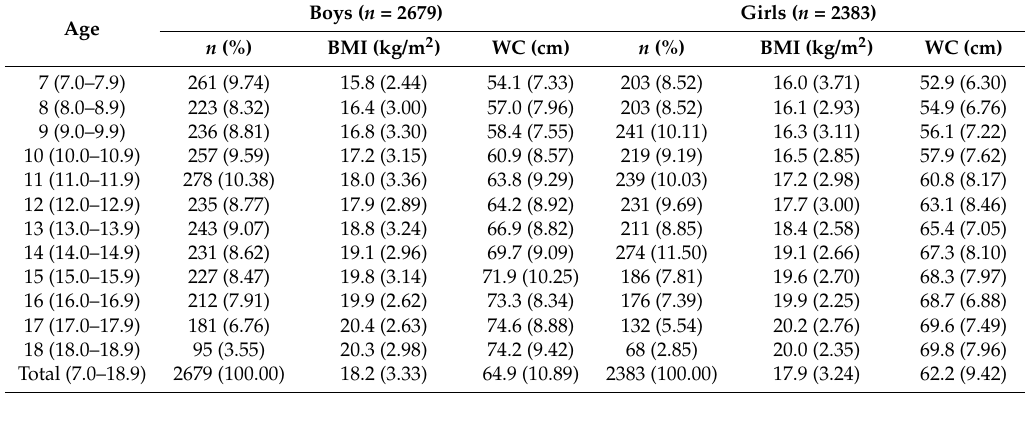
Table 1. Characteristics of the anthropometric records ( n = 5062, mean (SD)).